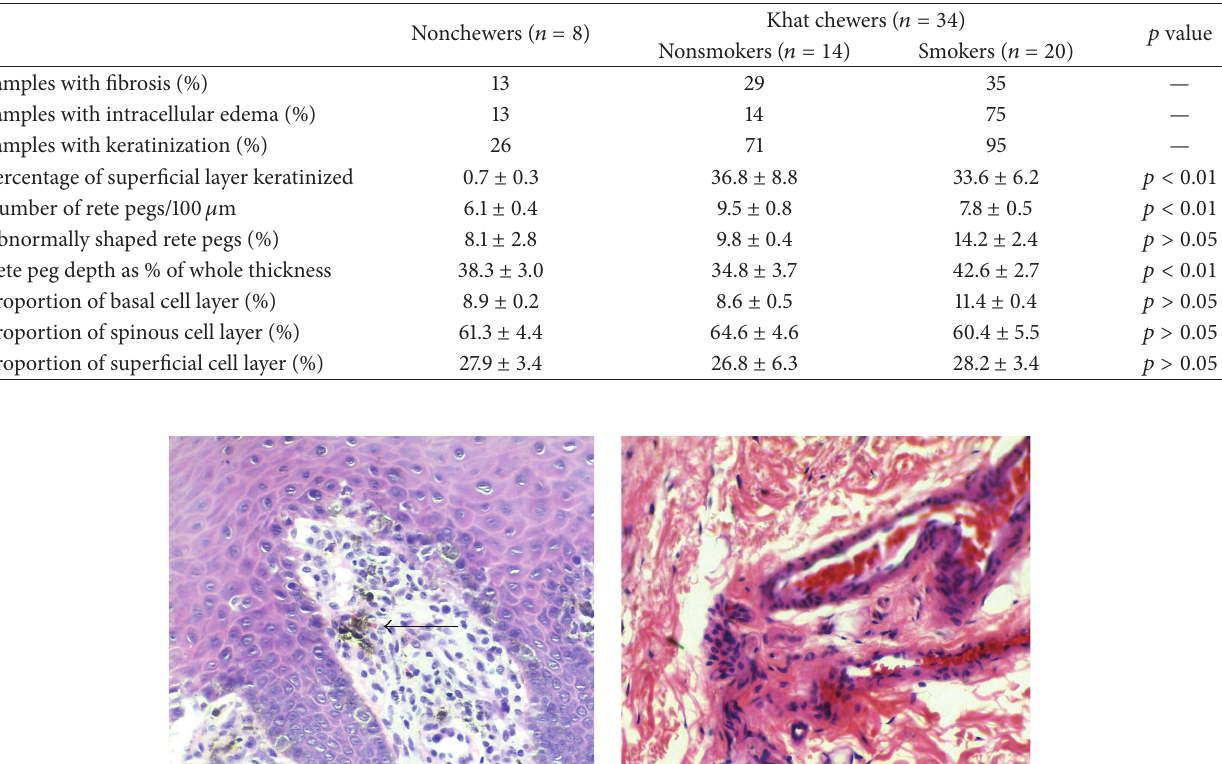
Table 2: Analysis of histological changes in the buccal mucosa.